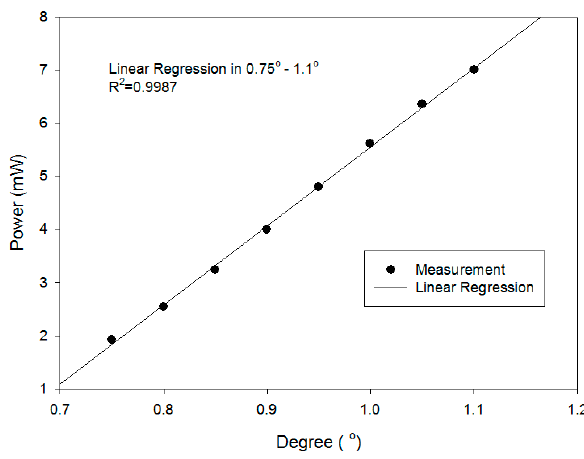
Figure 7. The linear regression of intensity versus angle variation.